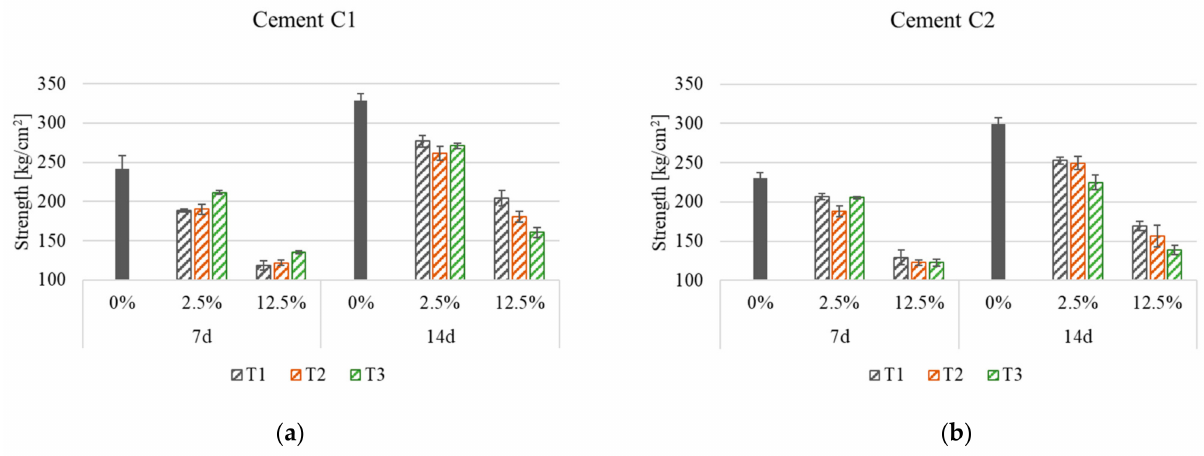
Figure 7. Compressive strength of mortar samples with untreated rubber addition at 2.5% and 12.5% replacement, after 7 days and 14 days: ( a ) cement C1; ( b ) cement